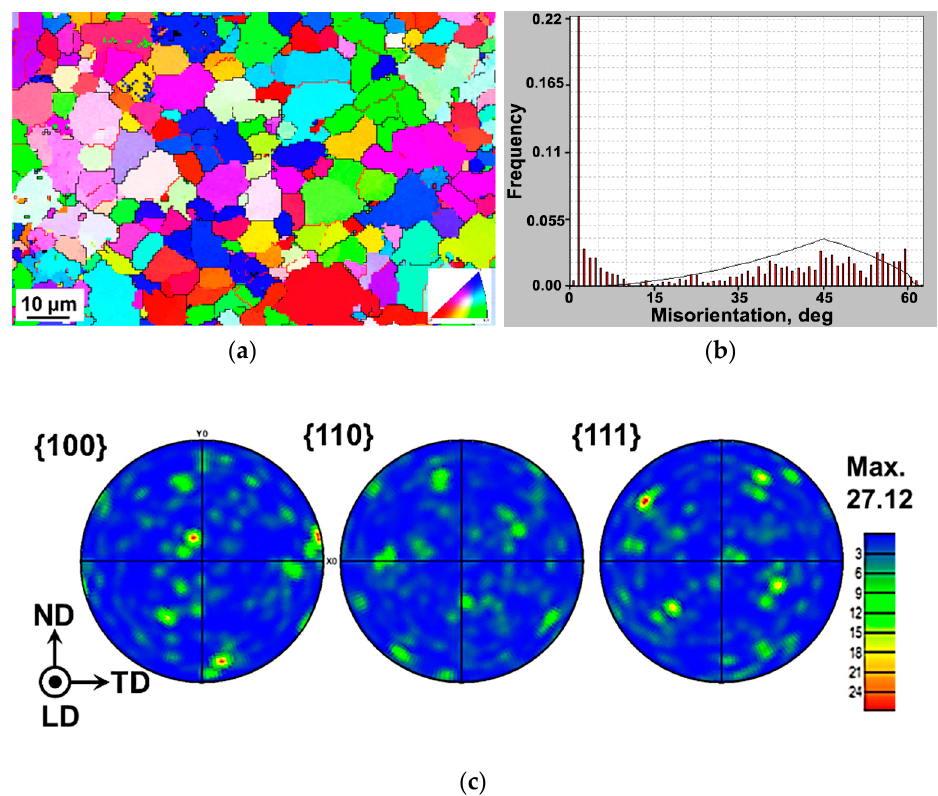
Figure 5. ( a ) Electron backscatter diffraction (EBSD) orientation map, ( b ) grain boundary misorientation angles, ( c ) {100}, {110} and {111} pole figures of the alloy in the heat-treated condition.